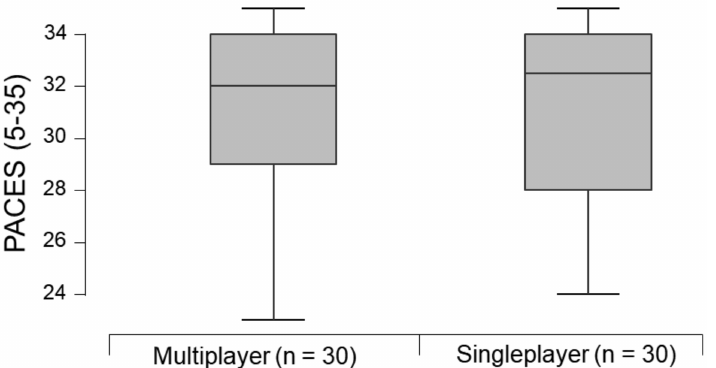
Figure 3. Comparison of the enjoyment level after a session of the exergame Kinect Sports ® beach volleyball between the single and multiplayer modes. There is no significant difference between modes ( p -value = 1.000). PACES: Physical Activity Enjoyment Scale.